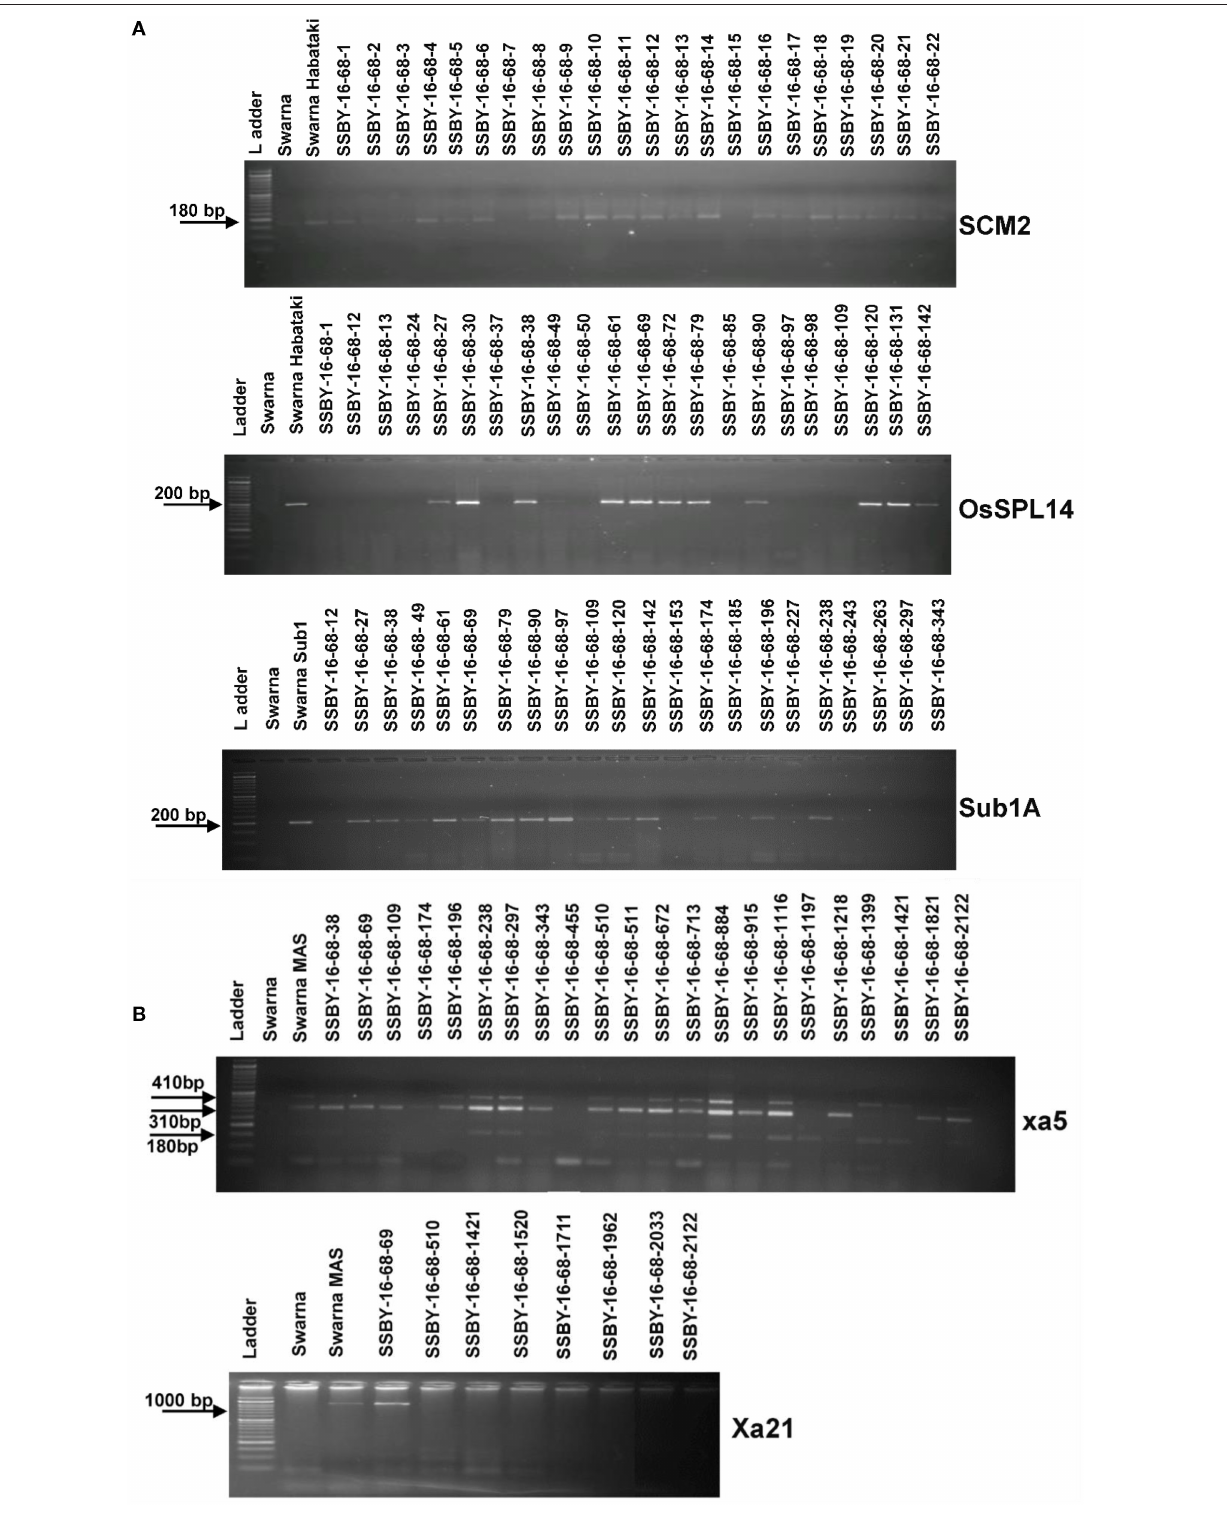
Frontiers in Plant Science |